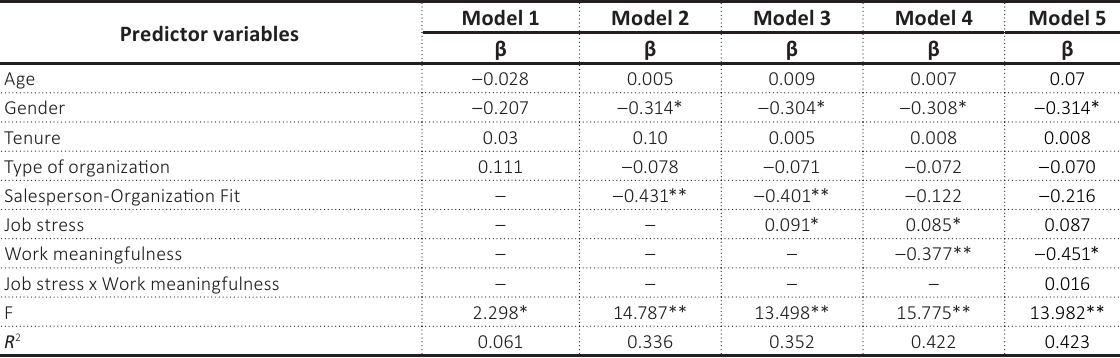
Table 3. Regression results predicting frontline